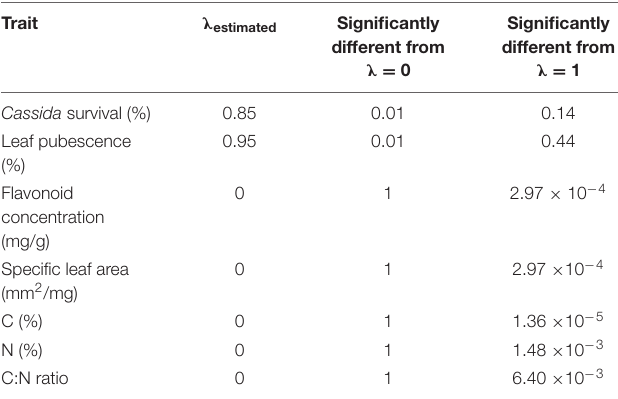
TABLE 1 | Phylogenetic signal (Pagel’s λ ) for plant traits and survival of Cassida rubiginosa . Trait